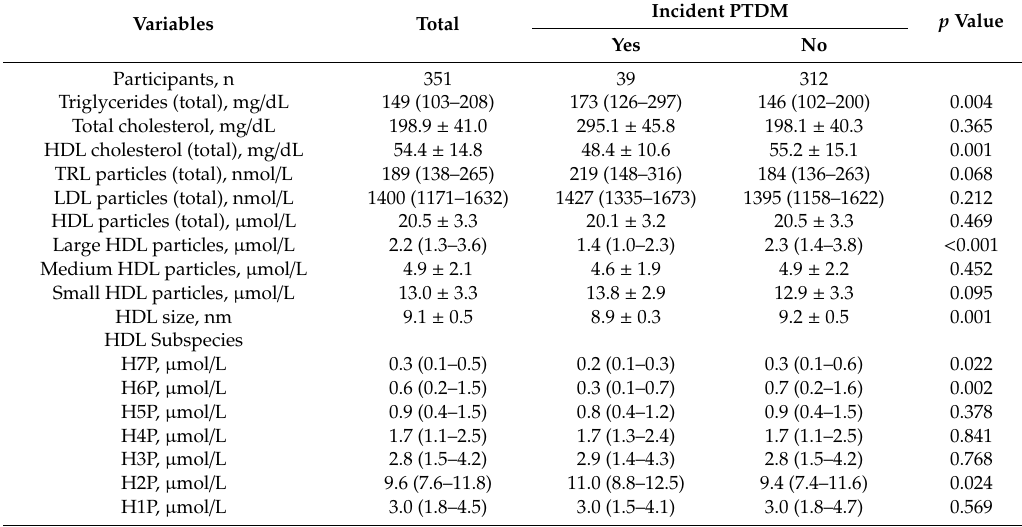
Table 2. Baseline Lipids and Lipoproteins Values of 351